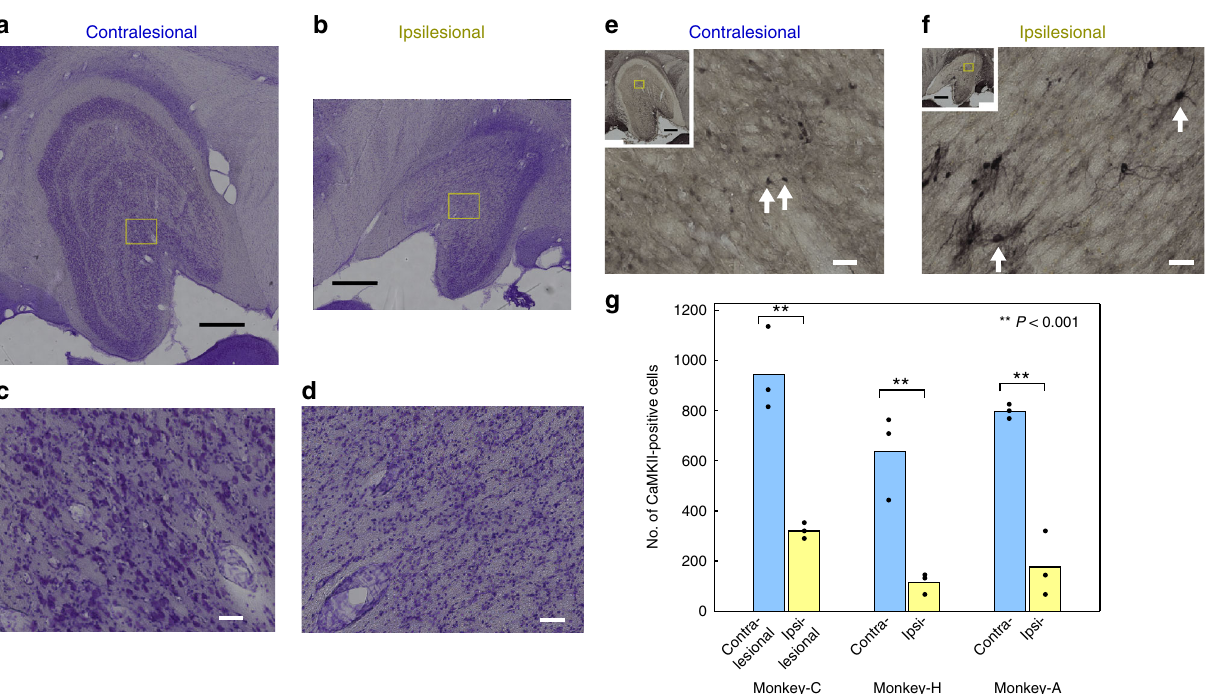
Fig. 7 Degeneration of the dLGN on the side of extensive V1 lesion. a – d The representative Nissl-stained coronal section of dLGN of Monkey-C. a , c Contralesional. b , d Ipsilesional. a – d were taken from a single histological section. On the ipsilesional side, the size of dLGN was small (Supplementary Table 1), layer structure was unclear ( b ), and most of the large (10 μ m order) cells were missing ( d ). e , f The representative anti-CaMKII immunostained dLGN (adjacent to the section of a – d ). e Contralesional. f Ipsilesional. The CaMKII-positive cells look swollen on the ipsilesional side (arrow in f ). Scale bars: 1 mm for a , b and insets in e , f , 50 μ m for c – f . g Each bar represents the number of CaMKII-positive cells in the dLGN, averaged from three